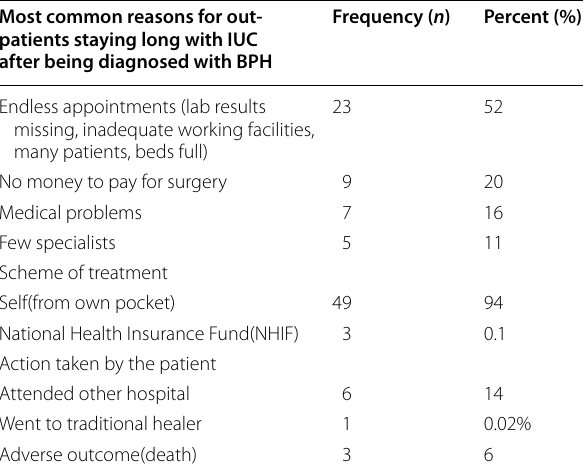
Table 2 Summary of most common reasons for